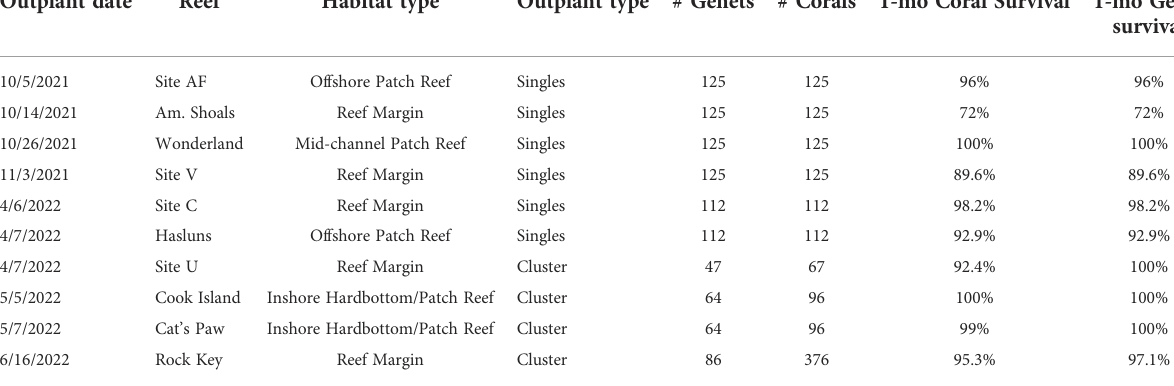
TABLE 2 Outplant and survival data for A. cervicornis sexual recruits produced via ASR in 2020 for active restoration purposes on Florida ’ s Coral Reef. Outplant